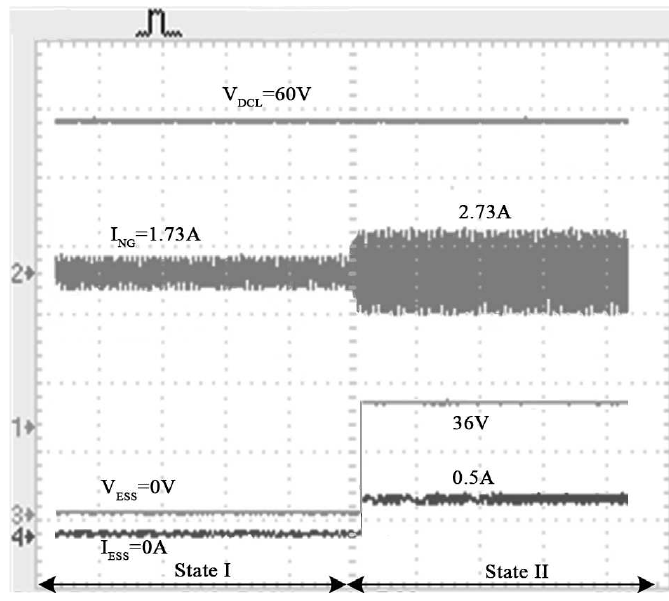
Figure 27. Experimental result for state I and